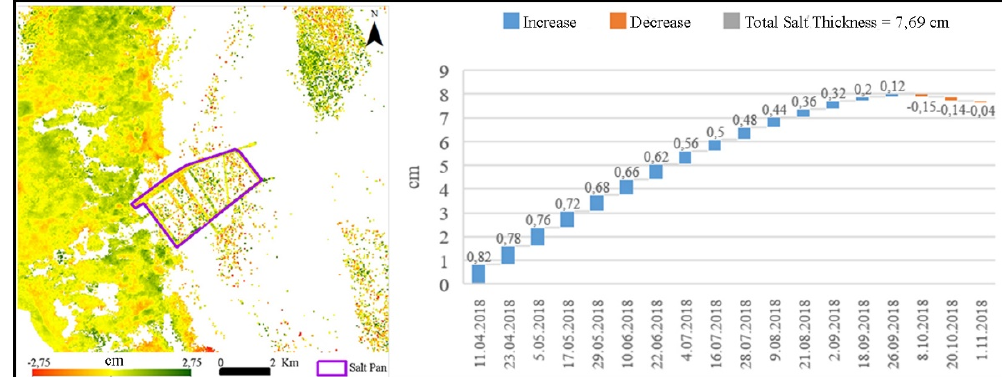
Figure 12. Salt movements obtained by SBAS results. The location of the salt pan is shown on the LOS directions SBAS map in the left image, while the change in the salt height in this salt pan is graphically displayed on the right (Calculations were made by converting to vertical units).